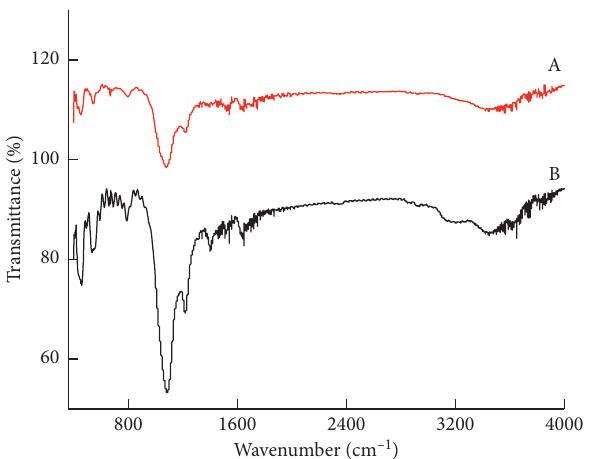
Figure 5: FT-IR spectra of ZSM-5 and Ni-ZSM-5 catalysts. A. Ni- ZSM-5; B. ZSM-5.